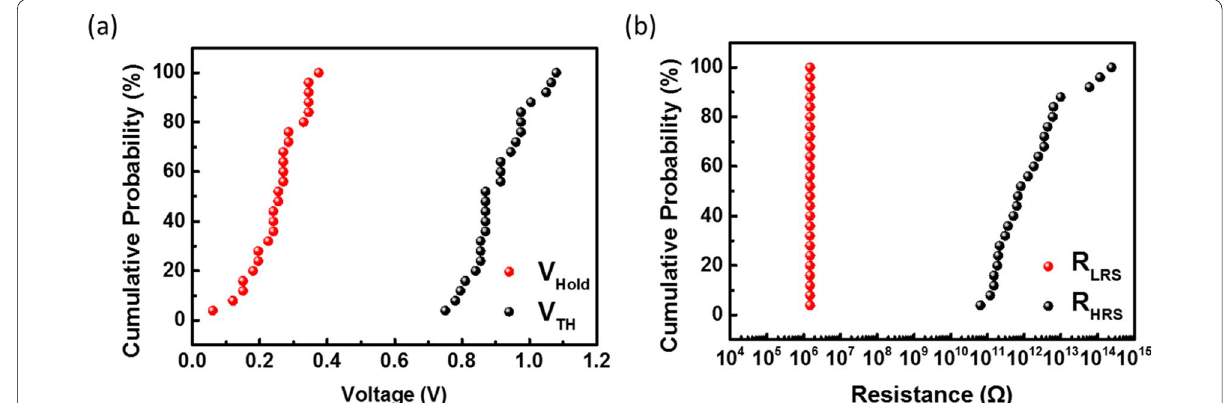
Fig. 4 a Device-to-device variations of V TH and V Hold for 25 devices. b Device-to-device variations of R HRS and R LRS for 25